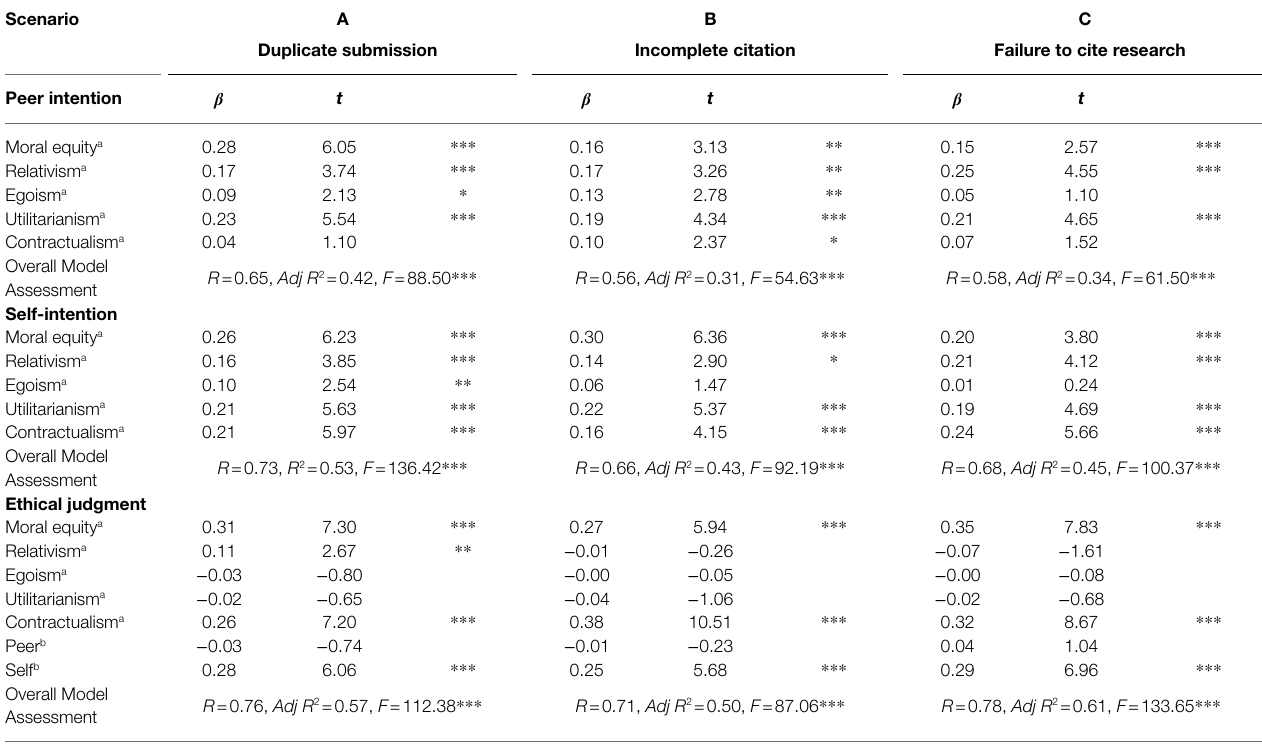
TABLE 5 | Regression analysis for variables predicting behavioral intentions and ethical